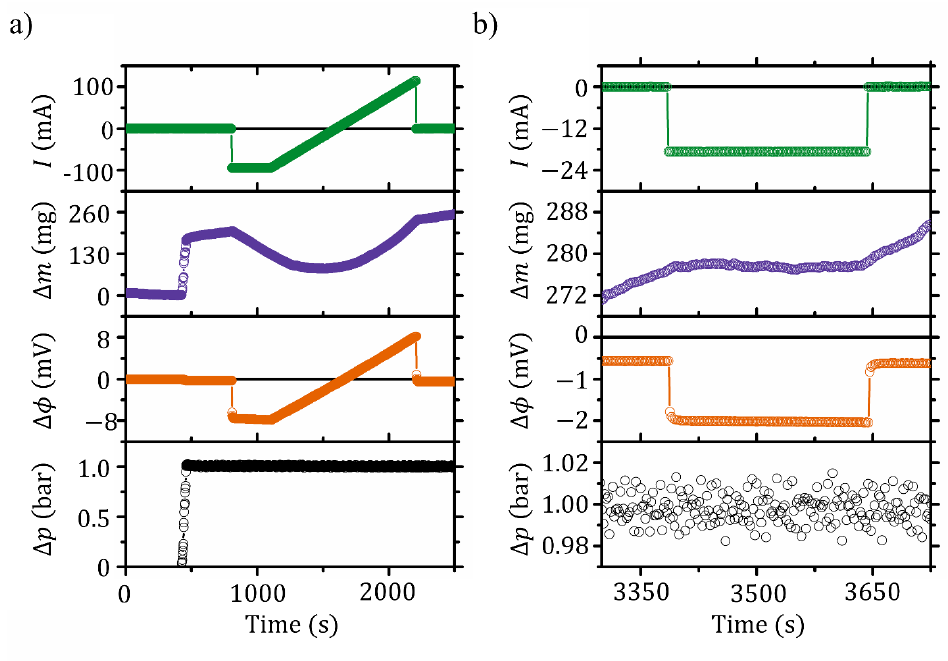
Figure 2. Raw data for the electrical current ( I ), mass transport ( ∆ m ), potential difference ( ∆ φ ), and logarithmic mean pressure difference ( ∆ p ) across the membrane as function of time. Noise levels are less than: 0.05 mA, 0.5 mg, 0.2 mV, and 0.04 bar, respectively. All values are positive toward the left-hand with respect to Figure 1a. ( a ) Shows raw data of an entire polarisation experiment; ( b ) is an excerpt of an event where the EKEC valve is closed and then opened